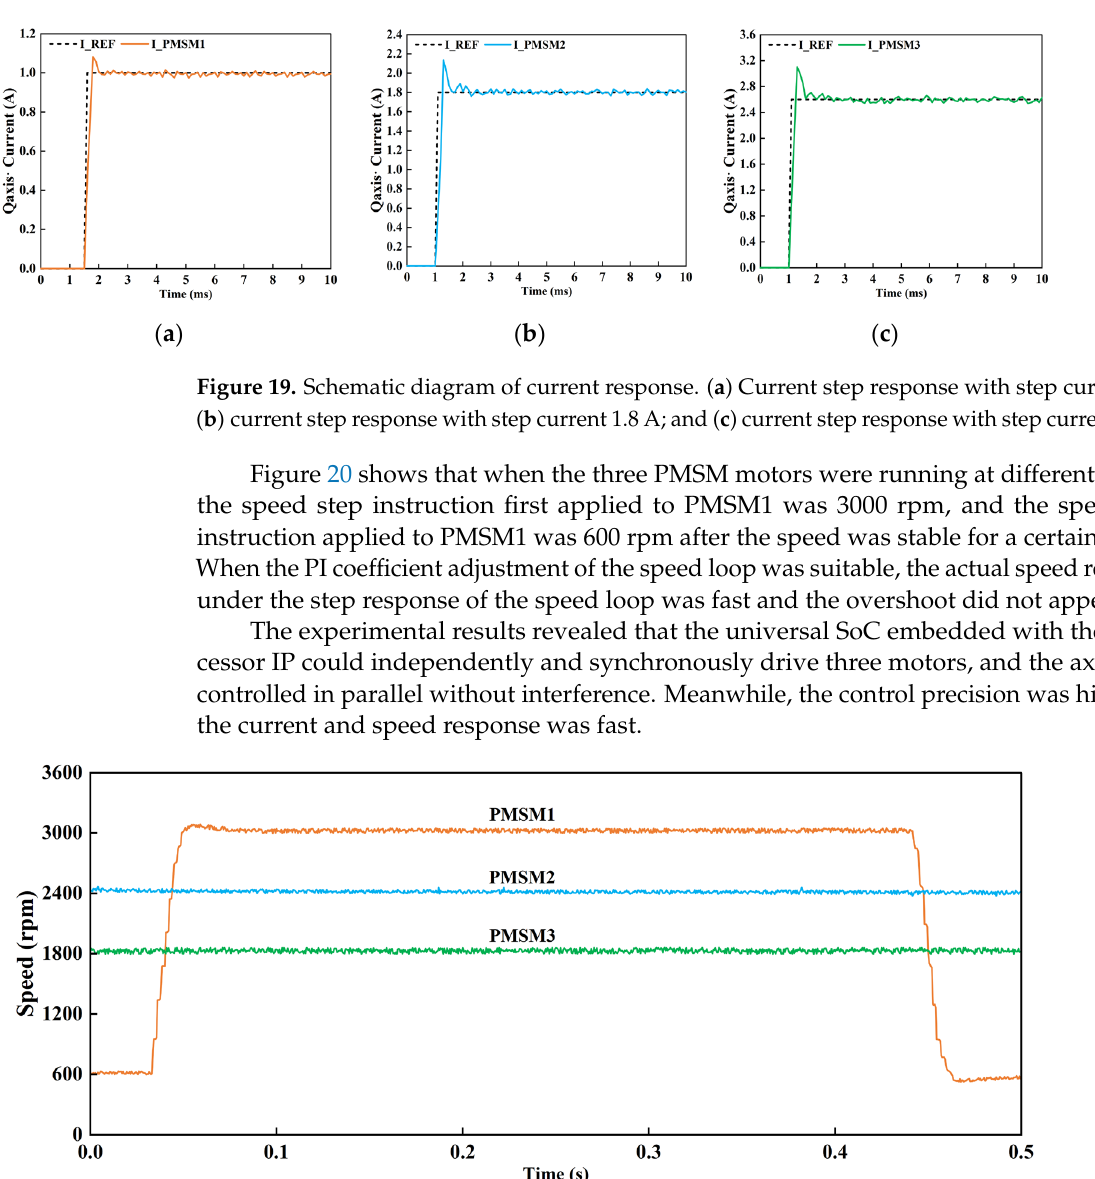
19 of 23 Figure 18. Schematic diagram of two-phase current of PMSM. 4.3.2. Multi-Axis Servo Control Performance Experiment Figure 19 shows the expected and actual current curves of the three-axis servo system working in the current loop. We tested the current step effect of three PMSMs. Figure 19a shows the torque current tracking of the first-axis PMSM with a current amplitude of 1 A;